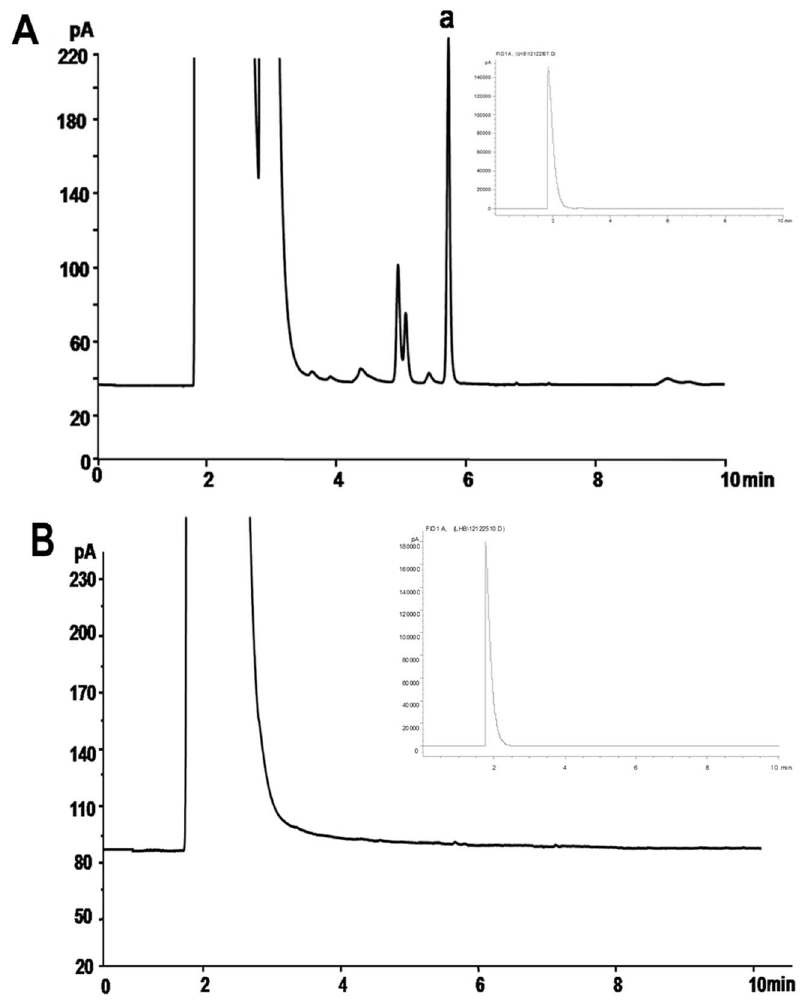
Figure 2. GC analysis of residual GTA content in the microspheres. (A) Partially enlarged GC chromatogram of 0.01% GTA. Top right corner shows the full chromatogram. (B) Partially enlarged GC chromatogram of blank microspheres (10 mg/ml). Top right corner shows the full chromatogram.